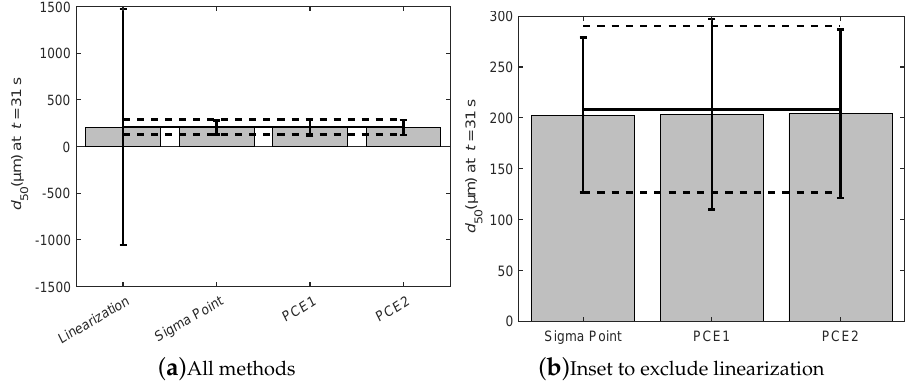
Figure 10. The different techniques with results from the Monte Carlo simulation (horizontal lines) using the d 50 value evaluated at 31 s. Figure ( a ) shows all four methods, while Figure ( b ) is an inset which excludes linearization due to its high confidence interval.